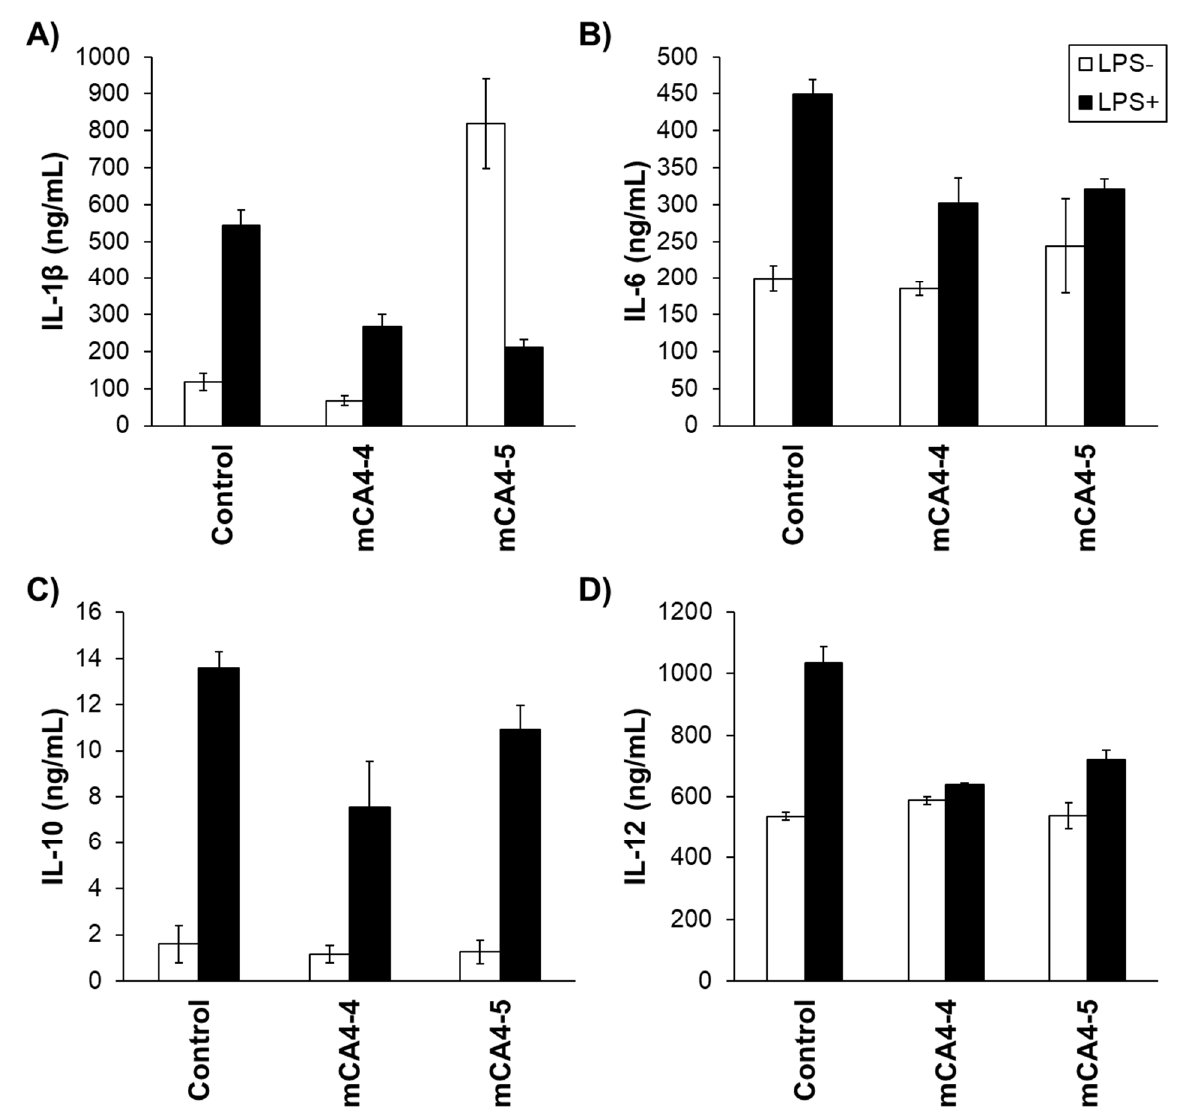
Figure 5. Release of cytokines ( A ) IL-1 β , ( B ) IL-6, ( C ) IL-10, and ( D ) IL-12 from HD11 macrophages treated with LPS and 100 µM peptides. LPS+ indicates macrophages stimulated by 1 µg/mL LPS, and LPS − indicates unstimulated macrophages. Error bars indicate the standard deviation of triplicates. White bar indicates the treatment of macrophages with peptides in the absence of LPS and black bar indicate the treatment of macrophages in the presence of